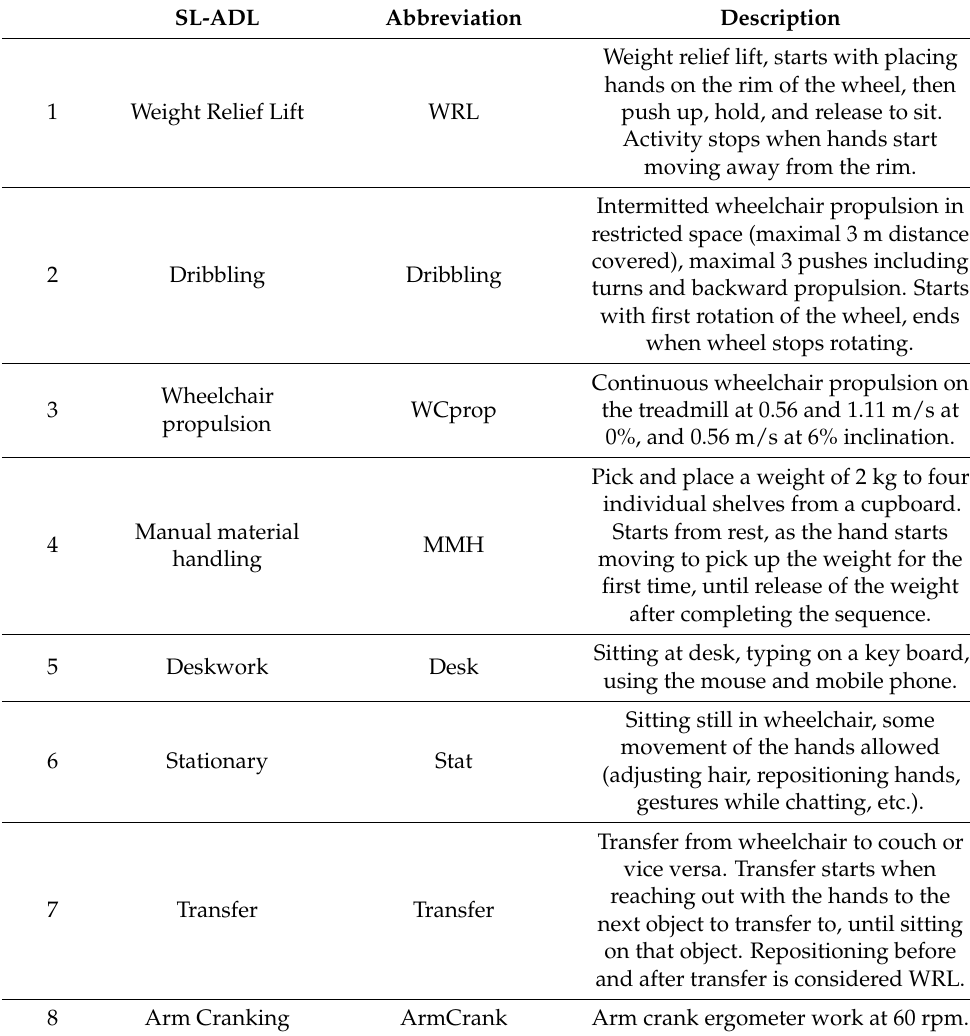
Table 1. A list of addressed SL-ADL and their description, used as instructions for the participants and as a definition for the annotation of the video